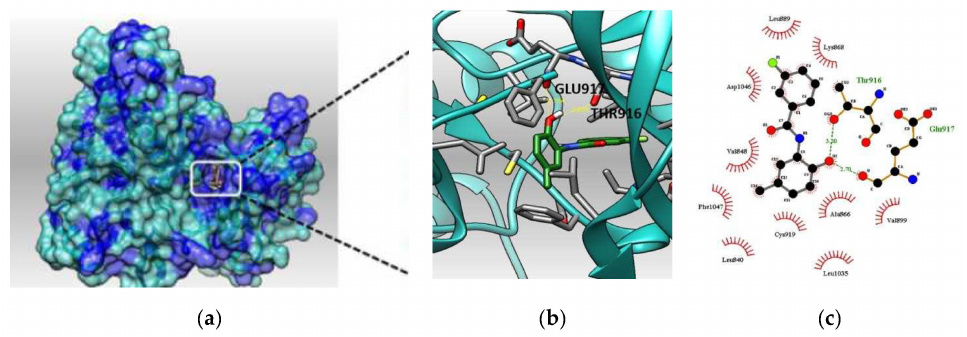
Figure 9. Interactions of the different isomers with the VEGFR-2 receptor. ( a ) The hydrophobic residues of the protein target are shown in dark blue tones. ( b ) The m -FPhB compound interacts with the GLU917 protein residue. ( c ) The representation in LigPlot + presents the hydrophobic residues with red lines and hydrogen interactions with a dotted green